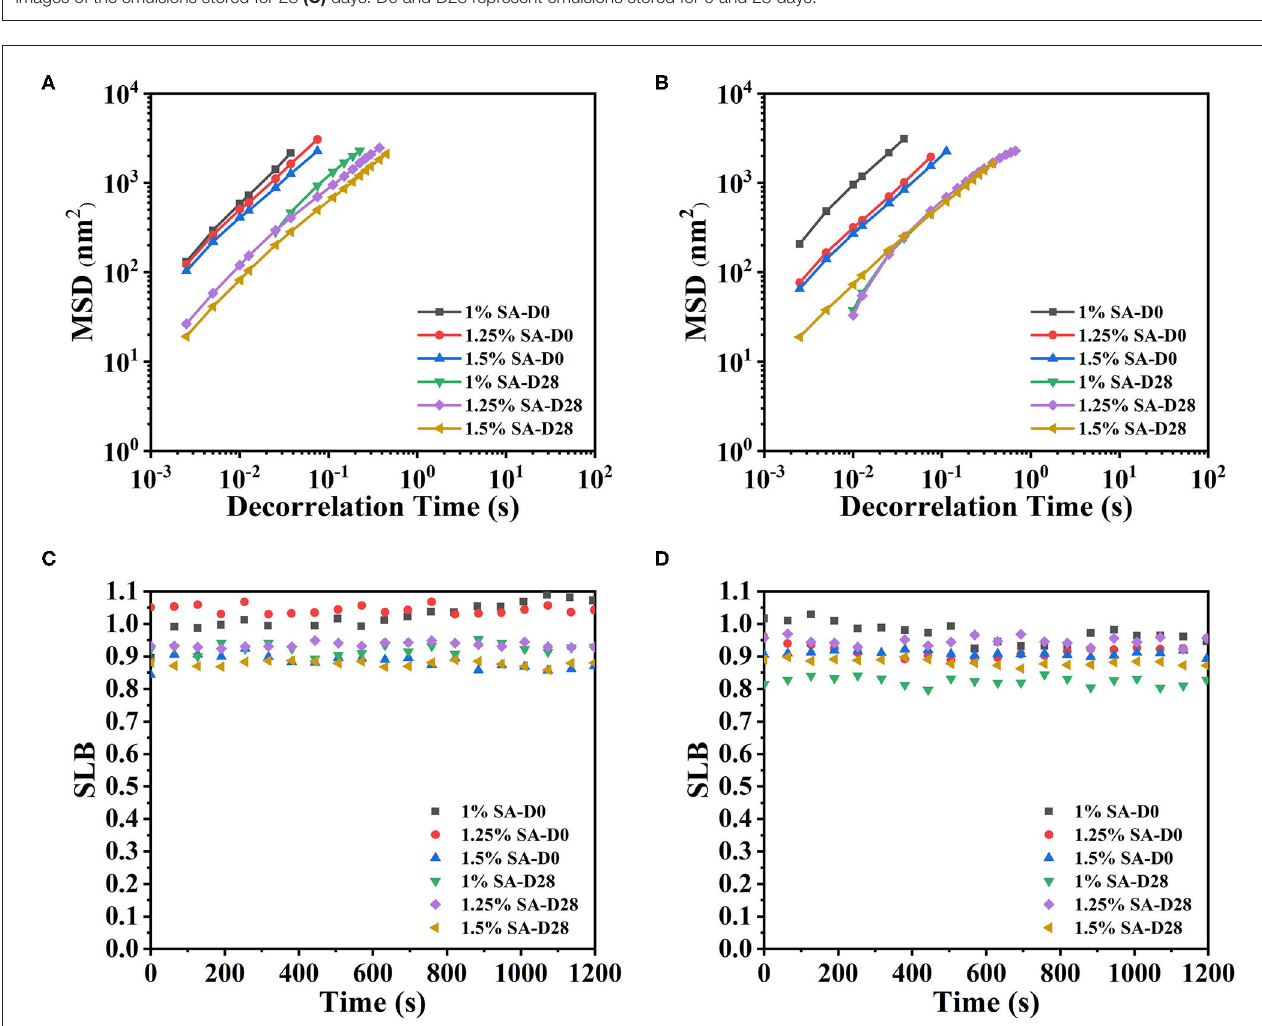
FIGURE 9 | MSD curves and SLB of O1 (A,C) , and O2 (B,D) emulsions. D0 and D28 represent emulsions stored for 0 and 28 days.